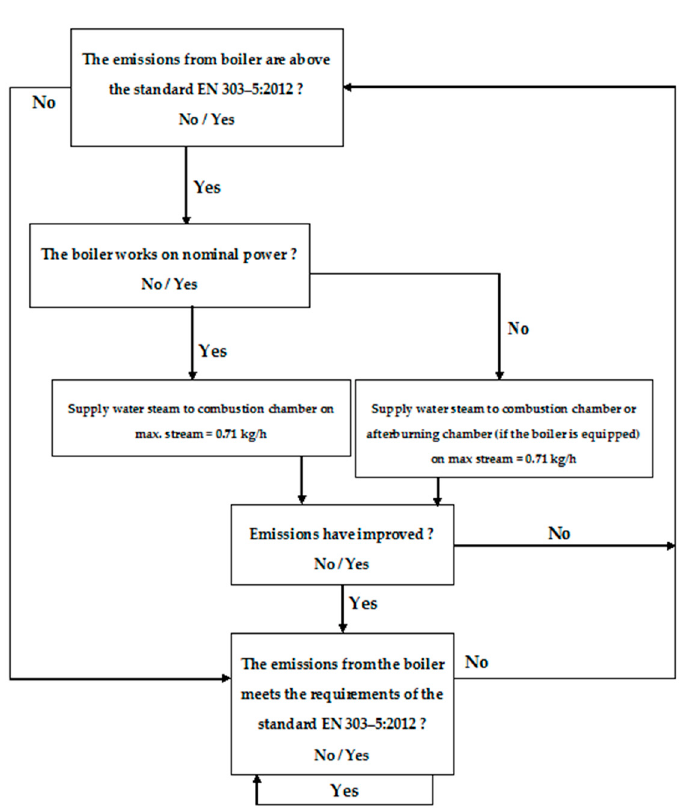
Figure 15. The scheme of the action algorithm developed for the solid fuel heating boiler system with steam water fed in order to limit the amount of harmful substances emitted.